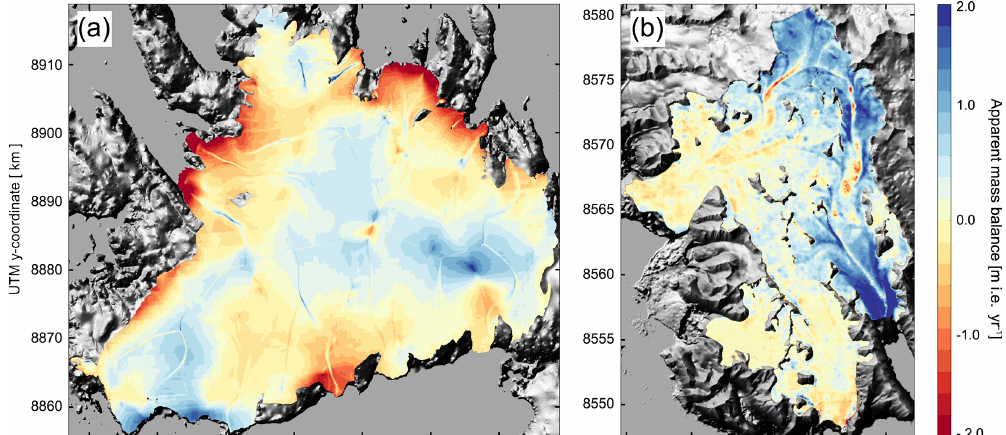
Figure B1. Final apparent mass balance ˙ a for VIC (a) , THPB and WSB (b) after minimisation of the cost function. During this minimisation, ˙ a is iteratively adjusted. The input values of ˙ a are presented in Fig. 2e and f. Background: grey-scale hill-shaded topography based on a NPI 50m DEM